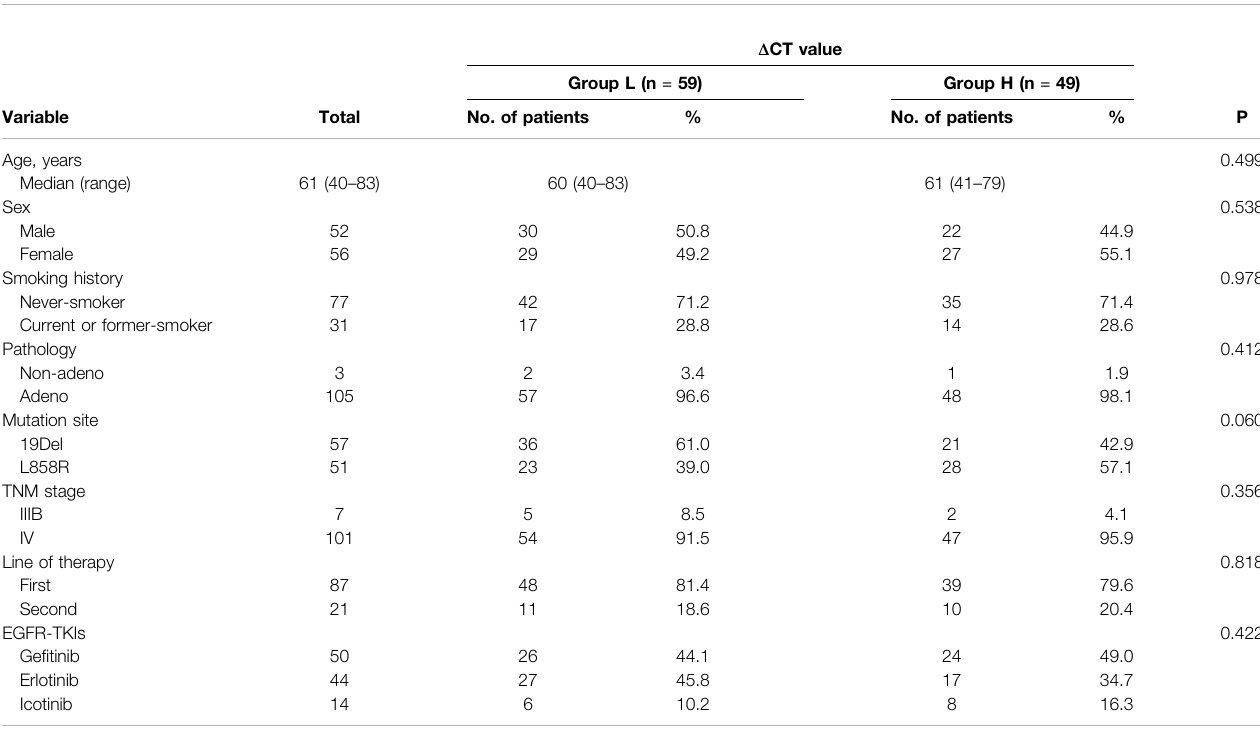
TABLE 1 | Patient demographics and clinical characteristics.